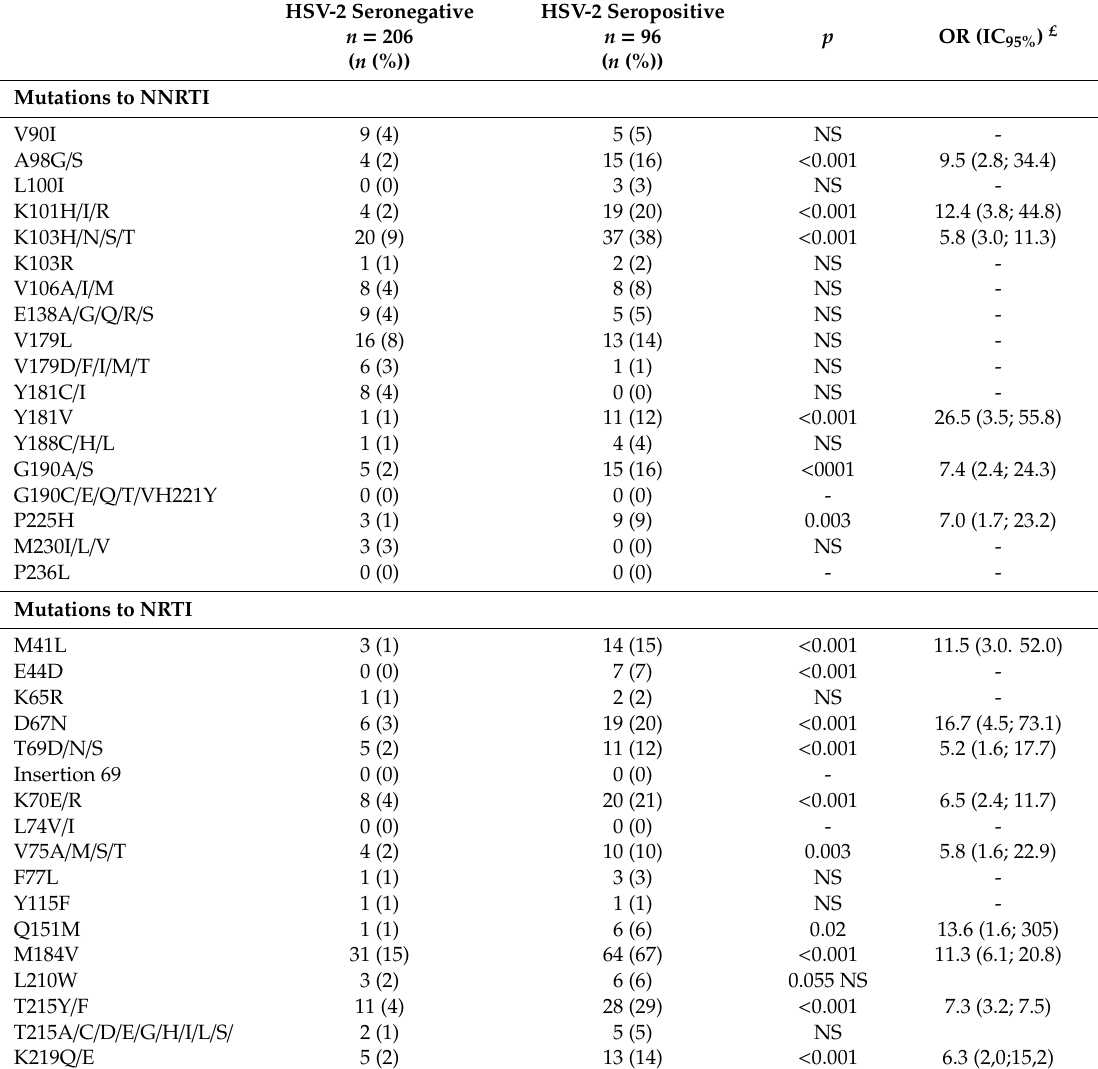
Table 3. HSV-2 seropositivity and selection of antiretroviral resistance mutations in the reverse transcriptase